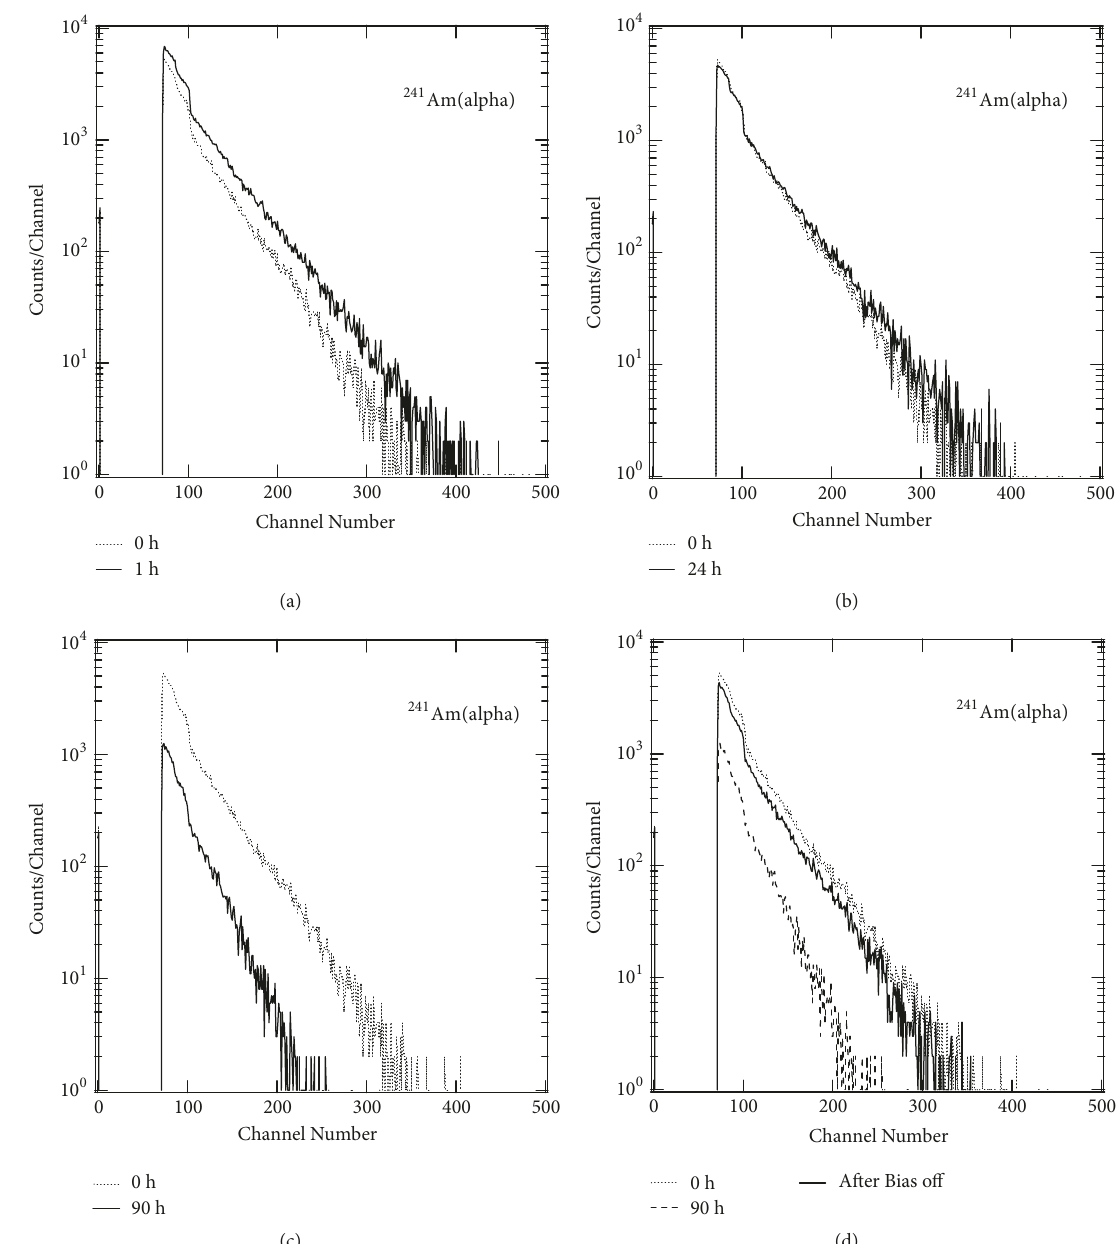
Figure 12: Alpha-particle energy spectra obtained from the SbI 3 detector as a function of operation time at room temperature.